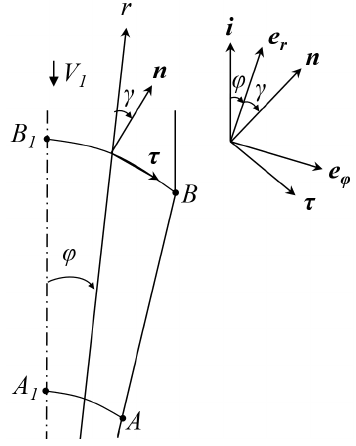
Figure 4. Geometry of velocity discontinuity lines.